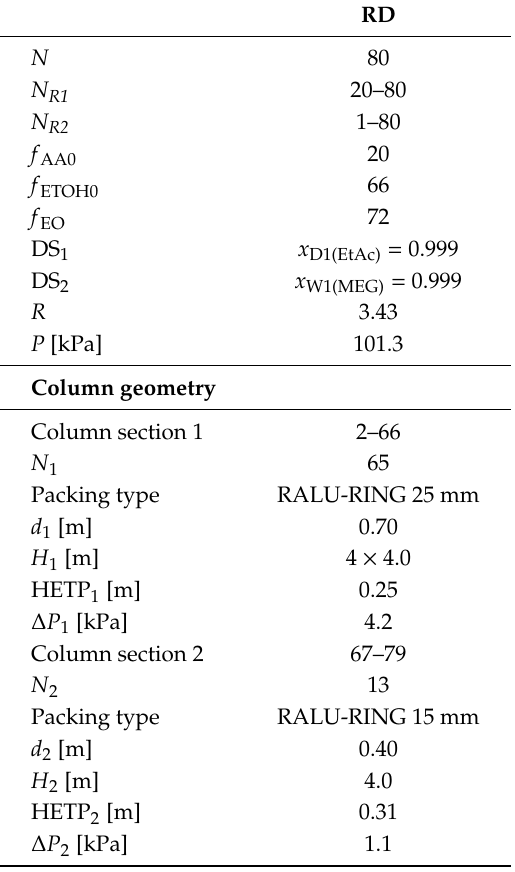
Table 8. Parameters of the designed column—RDAR (Figure